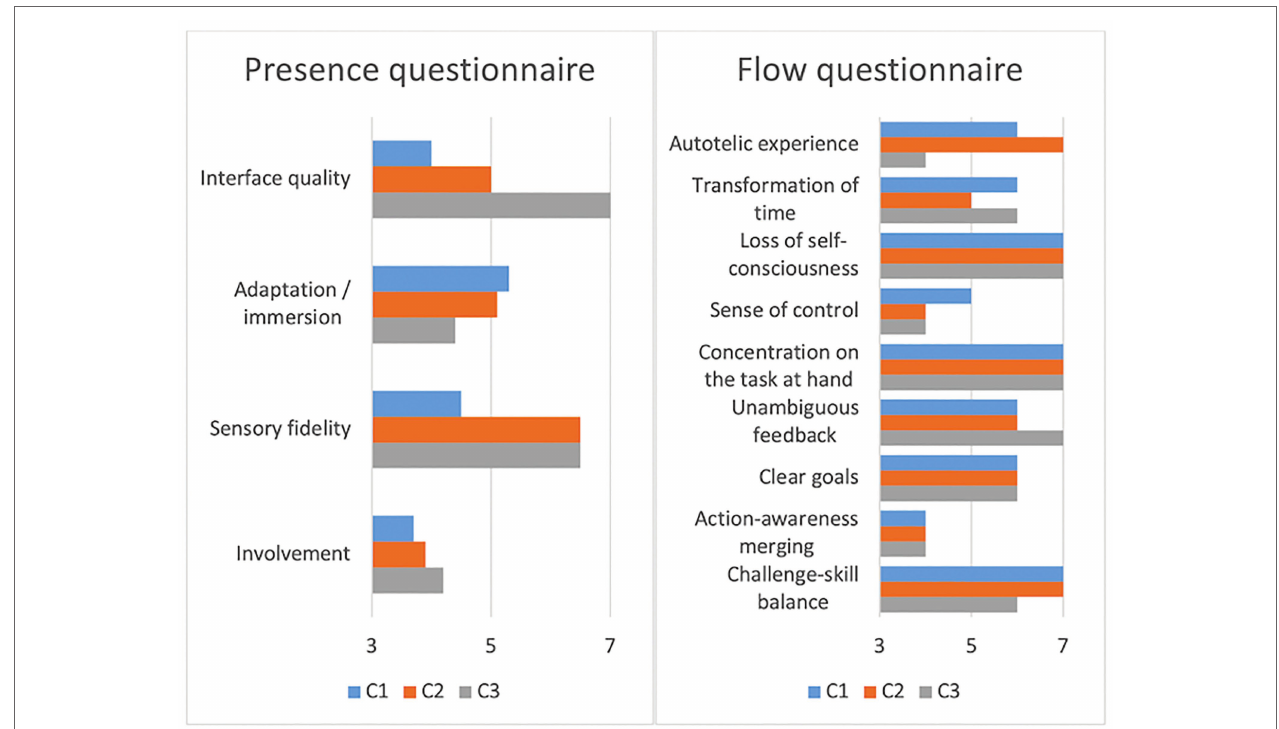
FIGURE 9 | Presence and flow scores of the Test pianist in all conditions (scores ranging from 1 = Strongly disagree to 7 = Strongly agree for the flow questionnaire and from 1 = Not at all to 7 = Completely for the presence